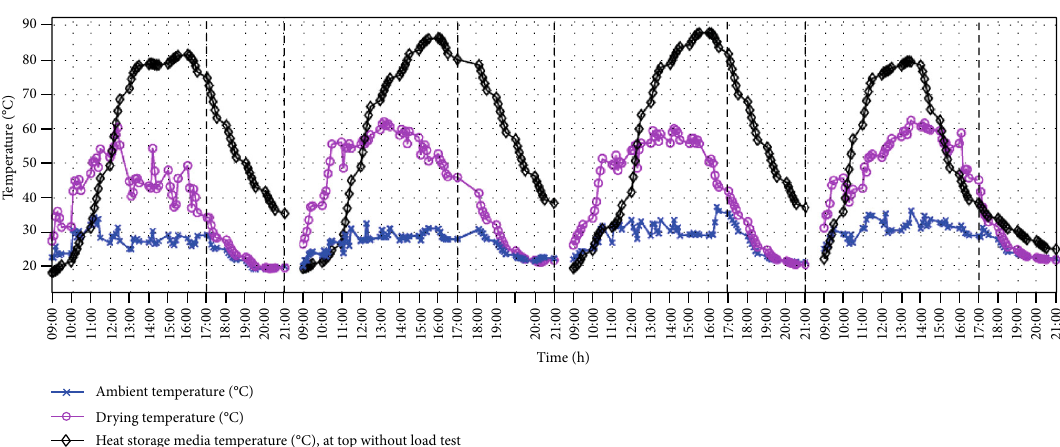
Figure 8: Variation of temperatures without load tests with time.